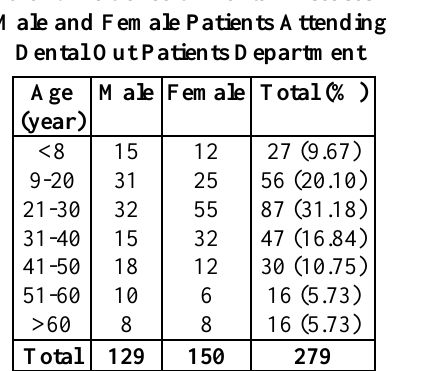
Table I. Incidence of Dental Diseases in